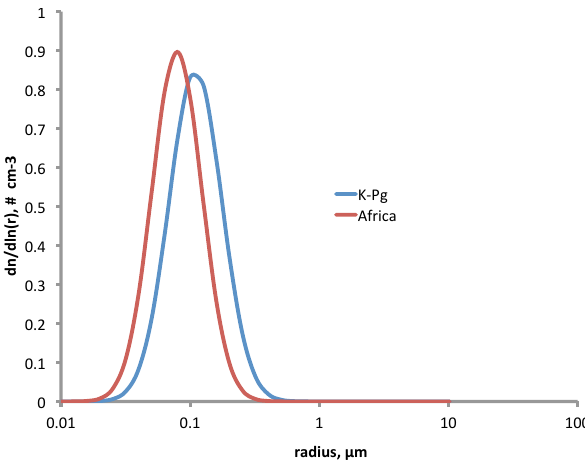
Figure 2. The size distributions for smoke from modern fires in Africa and from the K-Pg boundary layer (Wolbach et al., 1985; Matichuk et al.,